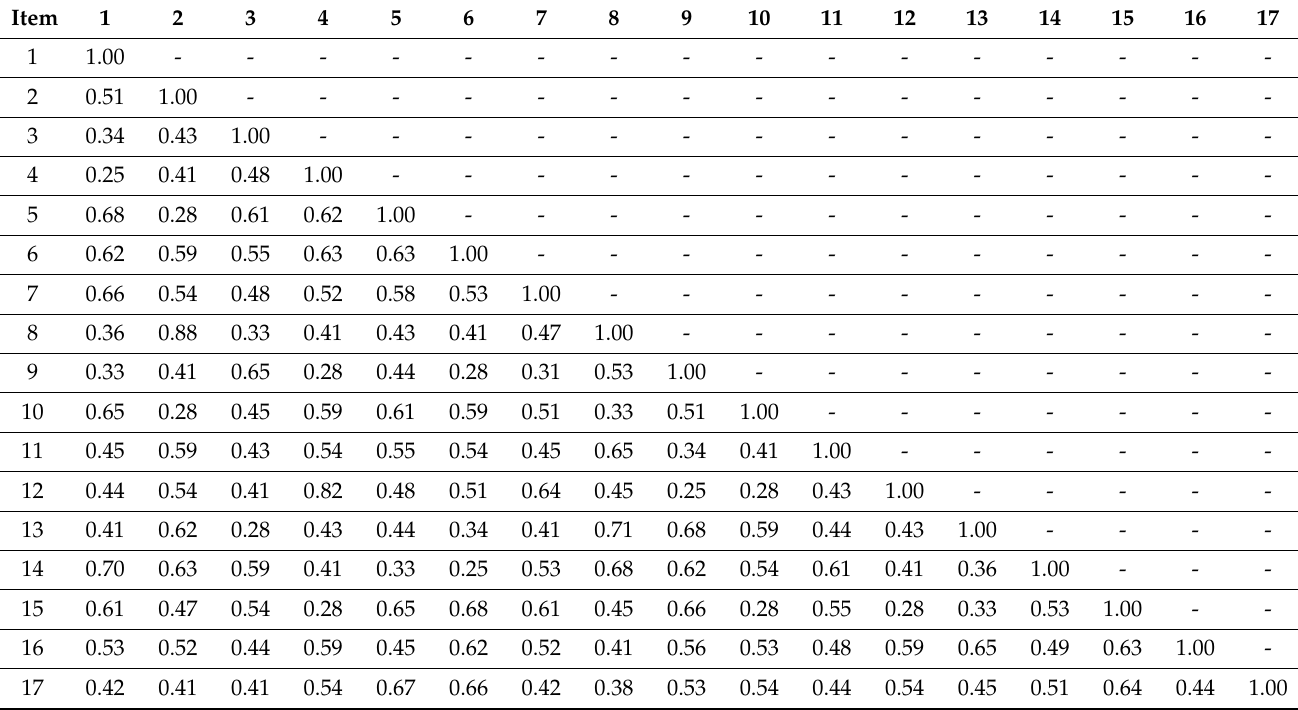
Table 3. Correlations between pain and fatigue TSK